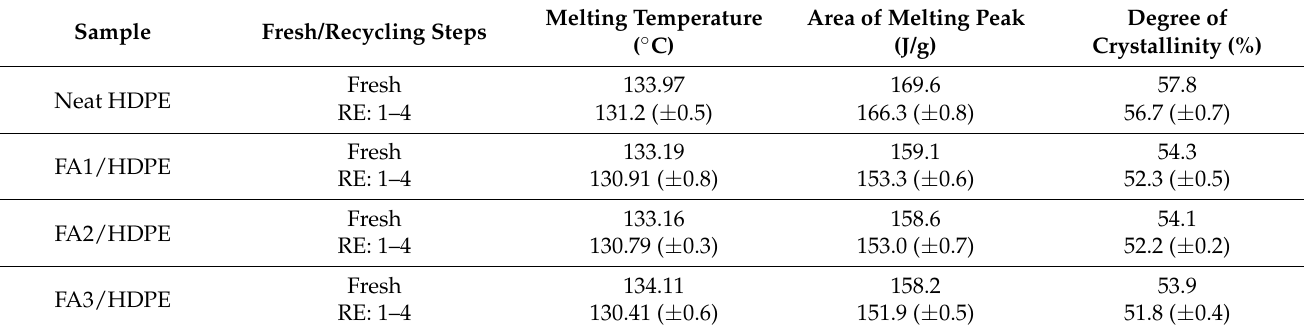
Table 1. DSC analysis results of the FA/HDPE